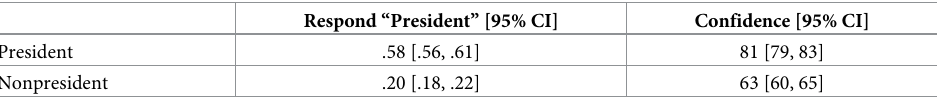
Table 1. Mean hit and false alarm rates and subjects’ mean confidence when responding “president” to an image in Experiment 1.